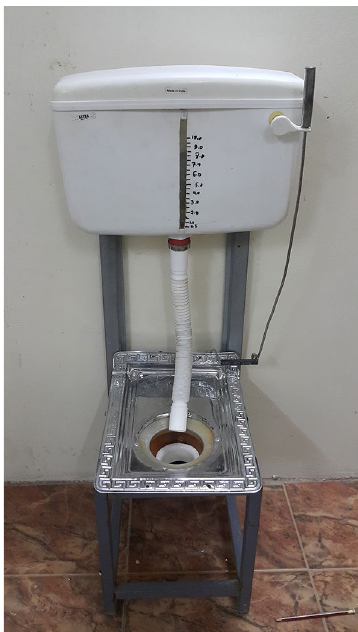
Fig. 8 The experimental setup for the proposed rotatable trapway sys- tem